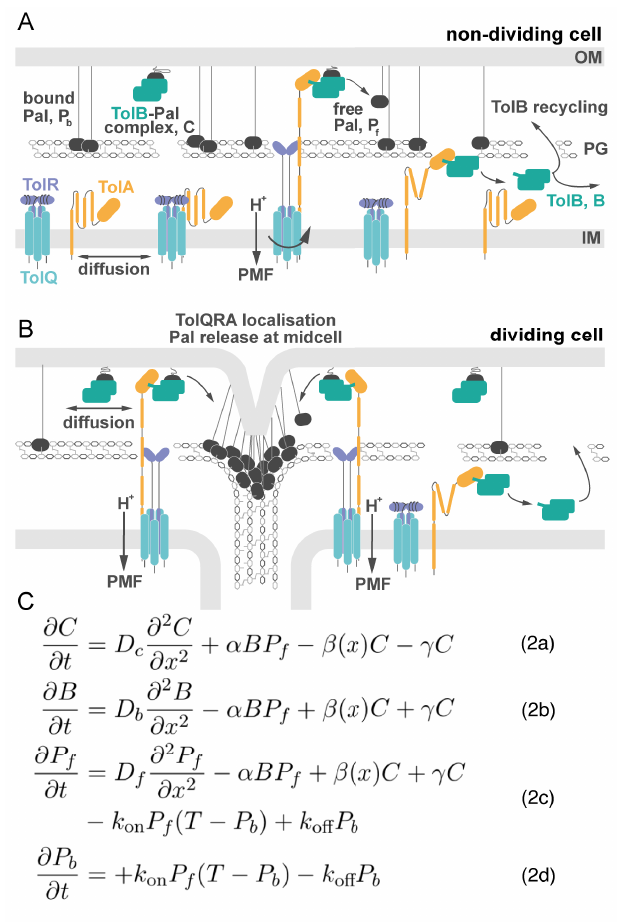
Fig 3. A minimal model of the Tol-Pal system. (A) Non-dividing cell: Here TolQRA is homogeneously distributed throughout the inner membrane. As a result, TolB is efficiently captured by the TolQRA machine and moved back into the inner periplasm. Pal is predominately free of TolB and hence binds to the peptidoglycan layer slowing its diffusion. (B) Dividing cell: TolQRA complexes become localised to the cell septum [7,8] such that TolB transport by TolQRA is localised to the centre of the cell. This leads to less overall transport of TolB, resulting in more TolB in the outer periplasm, where it binds Pal, increasing Pal mobility everywhere except at the septum. In this way TolB can mobilise Pal in dividing cells. (C) System of partial differential equations describing the main components of the Tol-Pal system. See the main text for explanation. machine at a potentially spatially-dependent rate β ( x ) or they can dissociate independently with rate γ . In either case the complex is broken down into free TolB, B ( x , t ), and a transient population of free Pal, P ( x , t ). We assume that the transient state of TolB bound to TolA disso- f ciates rapidly, consistent with their low affinity for each other [4,5]. Therefore, we do not explicitly model this state and instead assume that TolB is immediately returned to the inner periplasm, where it is free to diffuse. TolB can then migrate through holes in the PG layer to the outer periplasm where it can bind to free Pal to again form a TolB-Pal complex. We assume this to occur in one step with rate α . This assumption is justified by the relative abundance of Pal molecules (there are ~60,000 Pal and ~6,000 TolB molecules in the periplasm [14]. This is described in Eq (2B) and (2C). The transient free population of Pal is immobilised by binding to the peptidoglycan of the cell wall. This occurs with rate k but this is limited by the abun- on dance of PG binding sites T , which we take to be spatially uniform. This limitation prevents